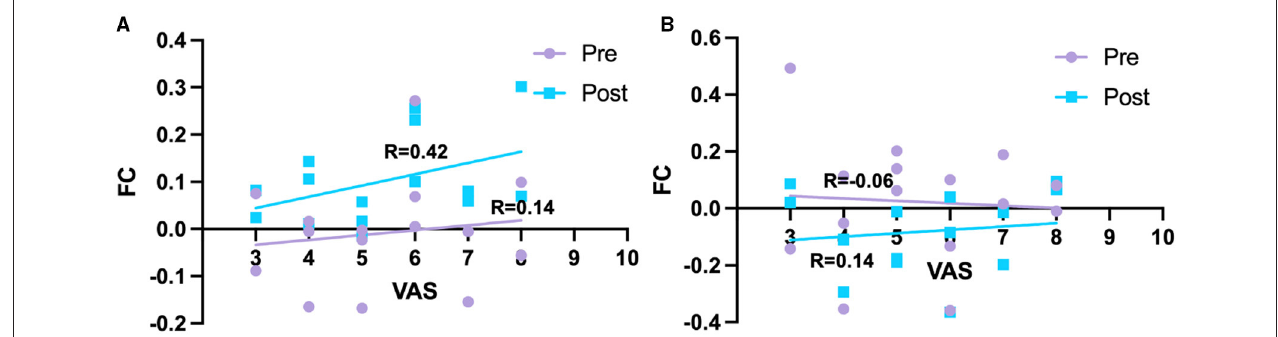
FIGURE 3 | Relationships between FC and pain intensity. (A) Correlation between FC of right putamen and pain intensity in KOA. (B) Correlation between FC of right cerebellum and pain intensity in KOA. Pre, pre-acupuncture; Post, post-acupuncture.